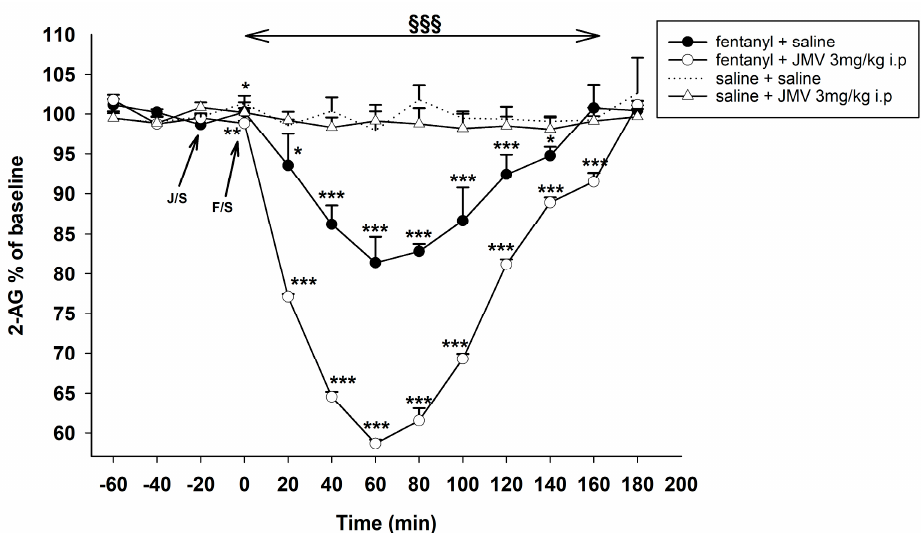
Figure 3. Effects of GHS-R1A antagonist JMV2959 3 mg/kg i.p. on the fentanyl-induced accumbens 2-AG concentration. JMV2959 was administered following three 20 min baselines and 20 min before fentanyl/saline (means ± SEM). The effects are illustrated as follows: saline + fentanyl (filled circle), 3 mg/kg JMV2959 + fentanyl (open circle), 3 mg/kg JMV2959 + saline (open triangle), saline + saline (dotting). Differences to saline + saline group are expressed as *** p < 0.001, ** p < 0.01, * p < 0.05. Differences between fentanyl + saline and 3 mg/kg JMV2959 + fentanyl effects are expressed as §§§ p < 0.001. The horizontal arrow shows intervals with appropriate significant changes ( §§§ ); the oblique arrows show the time of administration of J/S = JMV2959/saline and F/S = fentanyl/saline.